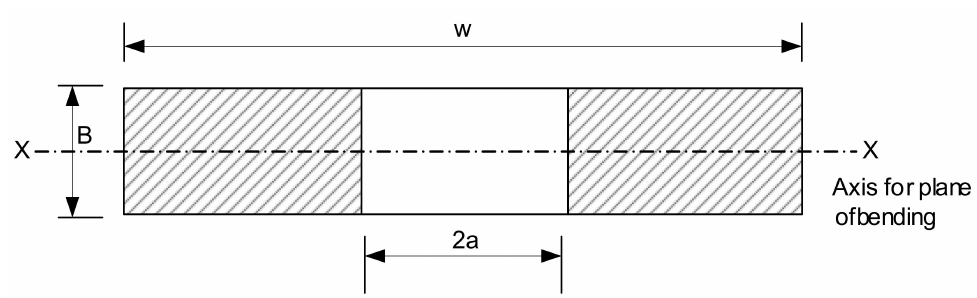
Figure 11. Flaw geometry for Zone